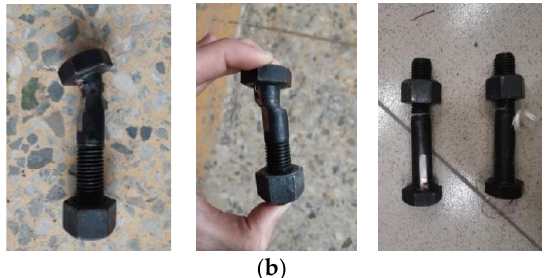
Figure 5. Typical specimen damage: ( a ) deformation of connections; ( b ) deformation of bolts.